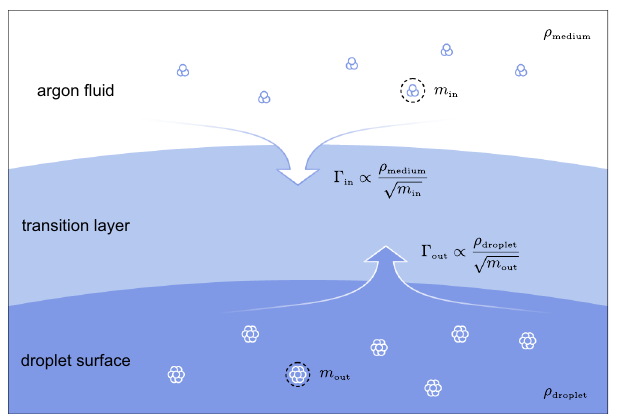
Fig. 6 Graphical illustration of the mass transport at a droplet surface. The emergence of clusters reduces the mass in fl ux, and consequently, the evaporation time of a droplet